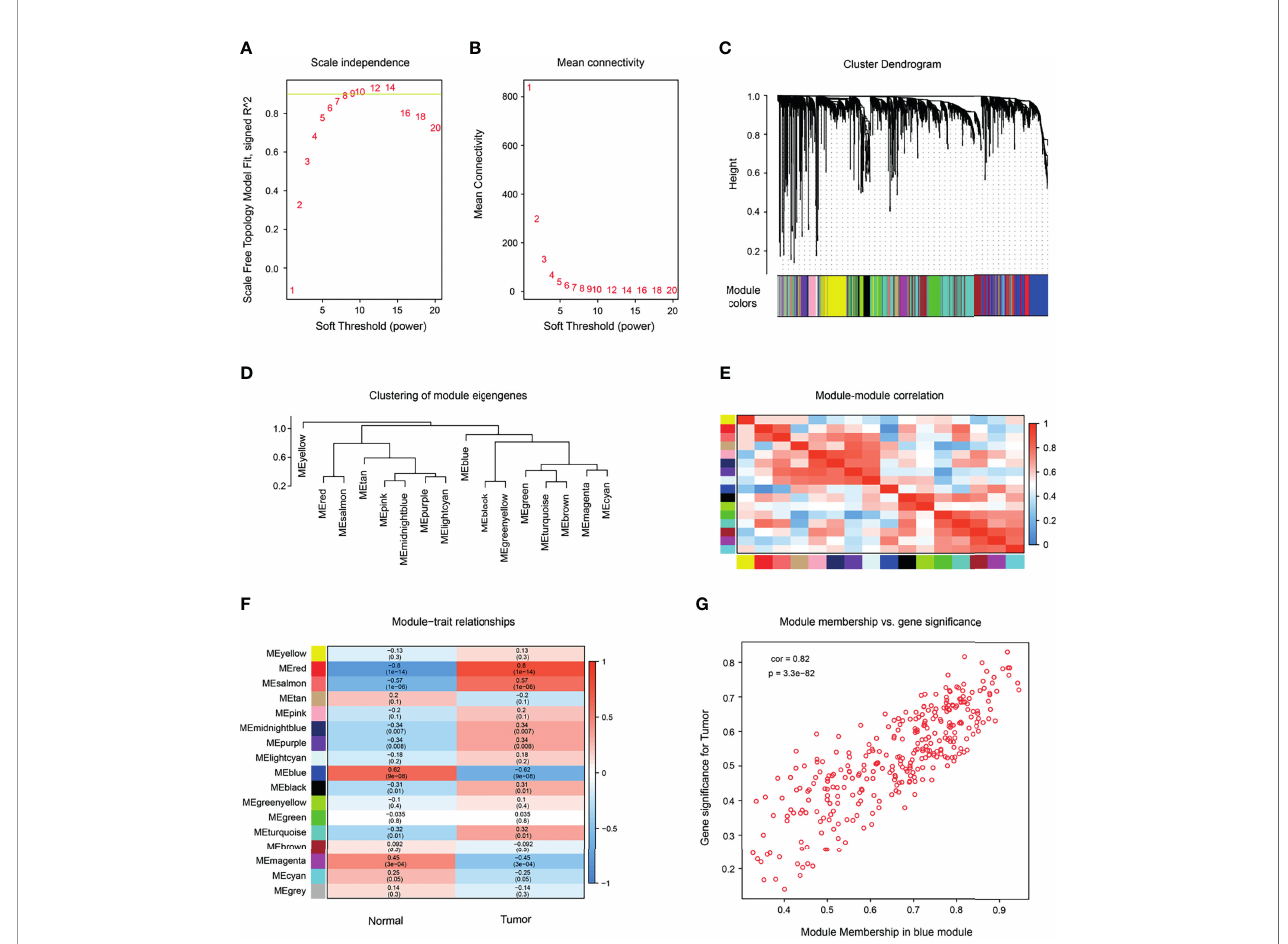
FIGURE 1 | Construction of a co-expression network by WGCNA. (A) Determination of soft-thresholding power in WGCNA analysis. Scale-free fi t index of WGCNA for various soft-thresholding powers ( b ). (B) Analysis of the mean connectivity under the different soft-thresholding powers. (C) Dendrogram of the differentially expressed genes (DEGs), clustered based on dissimilarity measure clustering (1-Tom). (D) Clustering of module genes. (E) Heatmap of the correlation among modules (red represents high correlation; blue represents low correlation). (F) Correlation between gene modules and clinical characteristics of melanoma (red indicates high positive correlation; blue indicates high negative correlation). (G) The relationship between gene signi fi cance and module membership of the blue module was